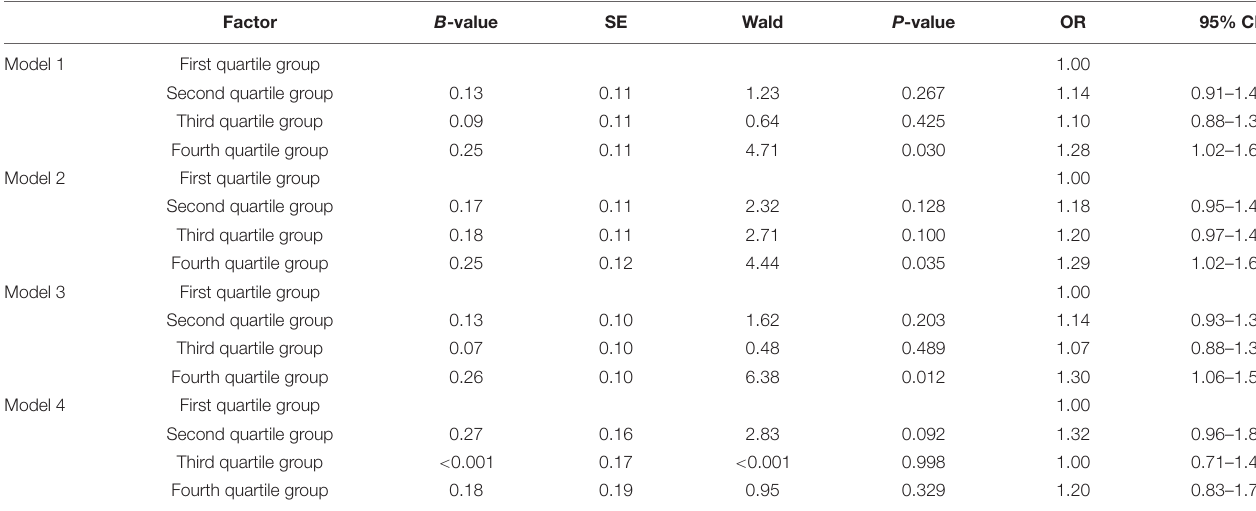
TABLE 3 | Multivariate logistic regression sensitivity analysis of baPWV quartile groups for